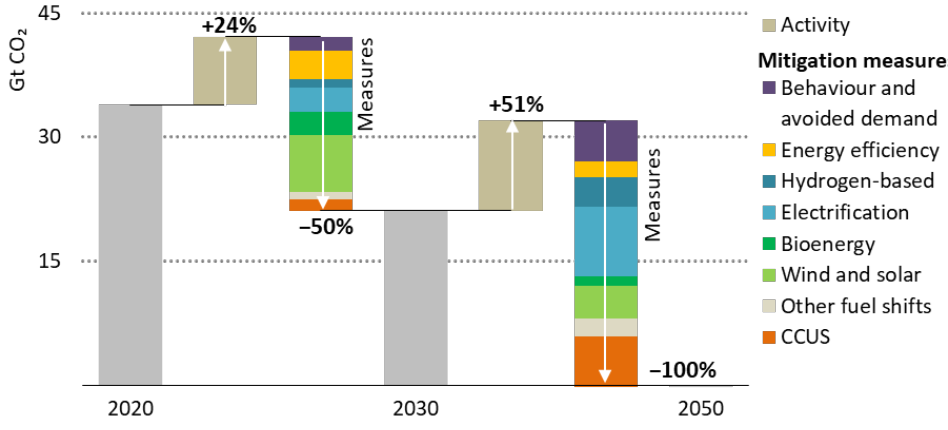
Figure 1. Decomposition of CO 2 emission reductions in 2030 and 2050 by mitigation measure ac- cording to the Net-Zero emissions scenario of the IEA [6]. CCUS: Carbon Capture, Usage,